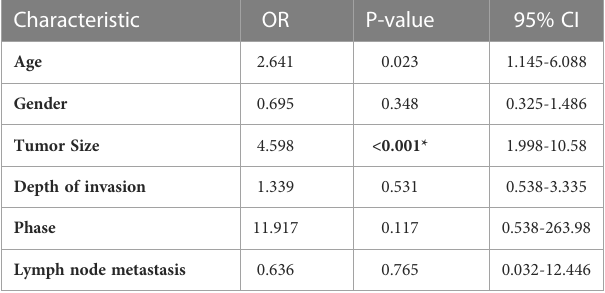
The bold values in the fi rst column mean Characteristic title. The bold values in the p-value column mean the result statistically signi fi cant. The symbol * means the result statistically signi fi